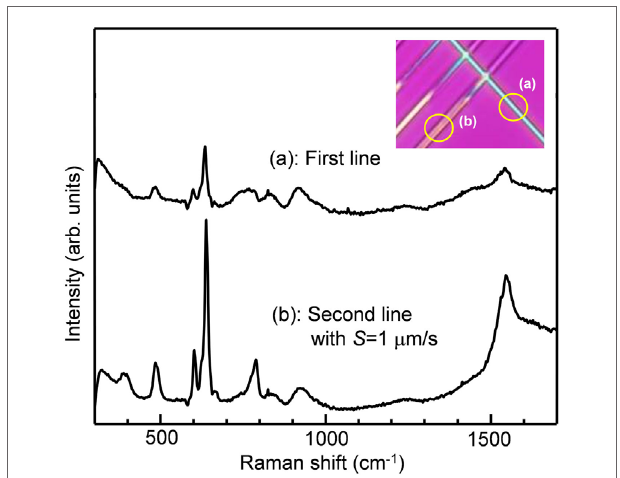
FigUre 5 | Micro-raman scattering spectra at room temperature for the first (a) and second (B) lines patterned by laser irradiation